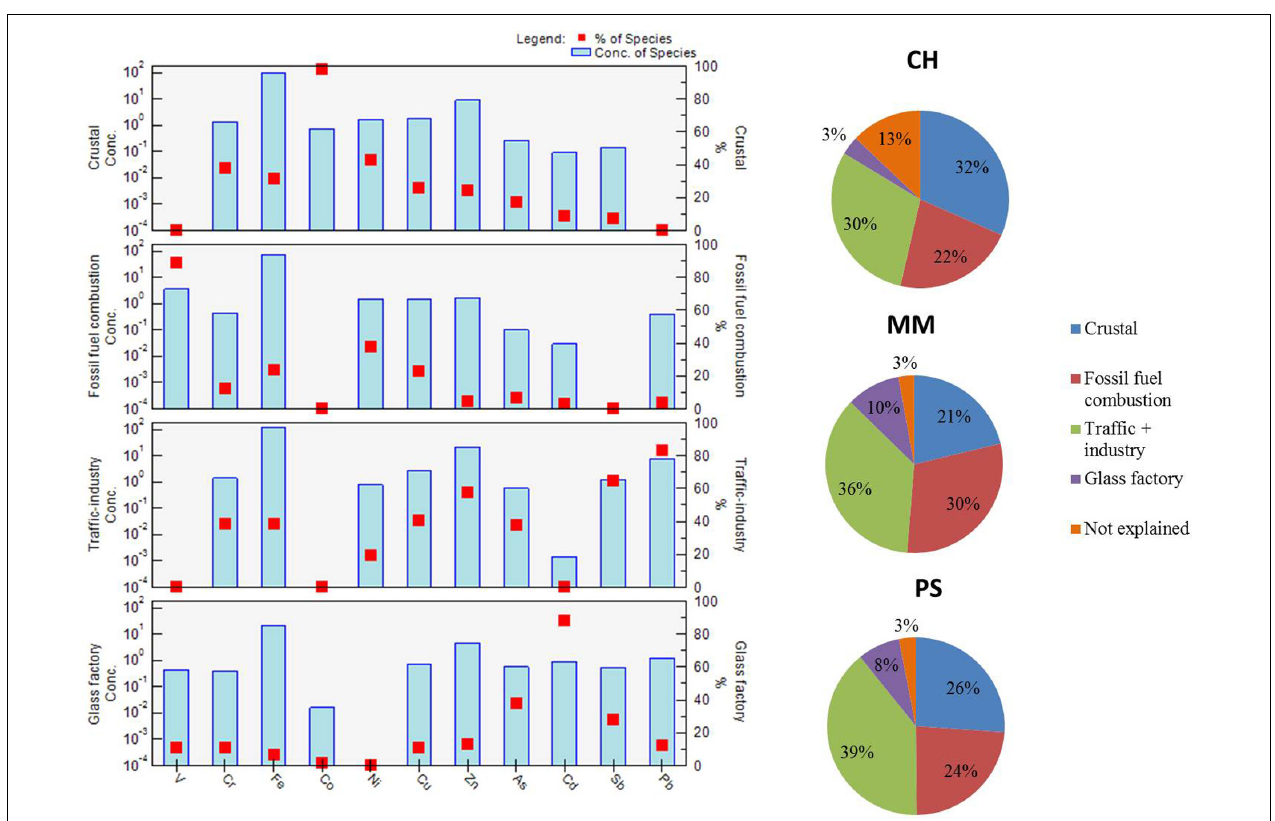
FIGURE 9 | On the left , factor source profile identified by PMF. Concentration of species are expressed both as absolute (ng/m 3 , left vertical axis) and relative concentration (%, right vertical axis). On the right , contribution of the factors, including the fraction of not explained concentration, in the monitoring sites of Chioggia (CH), Malamocco (MM), and Punta Sabbioni